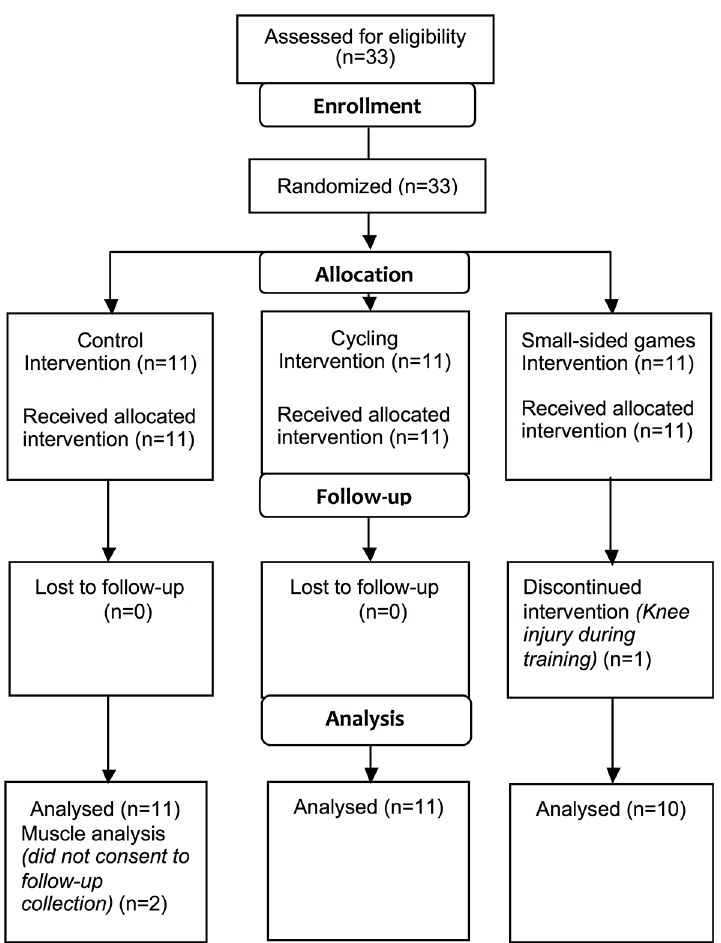
Fig 1. Schematic overview of participant numbers during enrolment, allocation, follow-up and analysis.